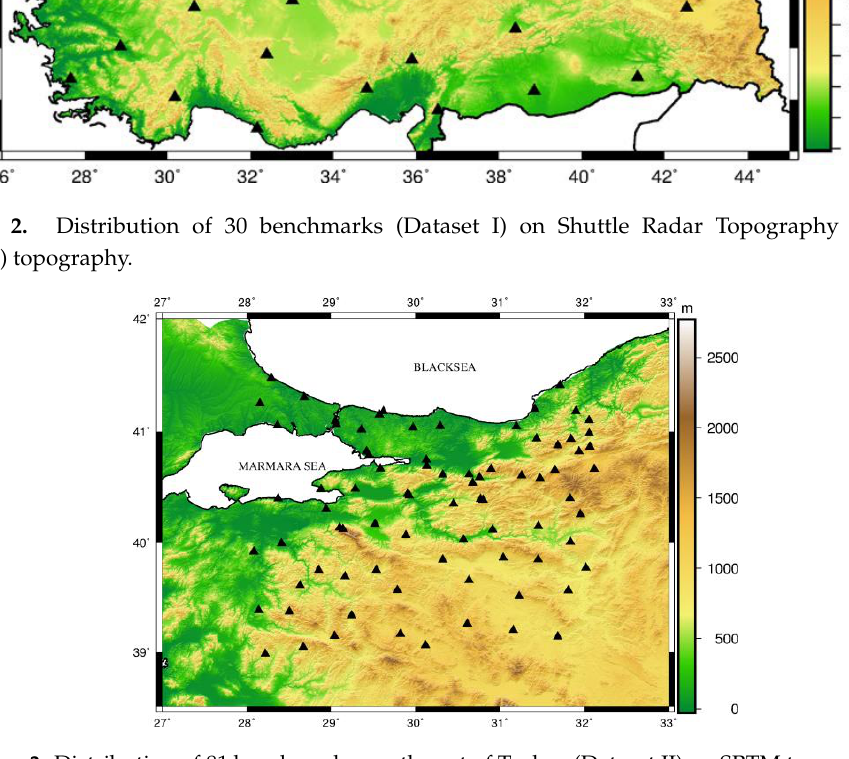
Figure 3. Distribution of 81 benchmarks, northwest of Turkey (Dataset II) on SRTM topography.